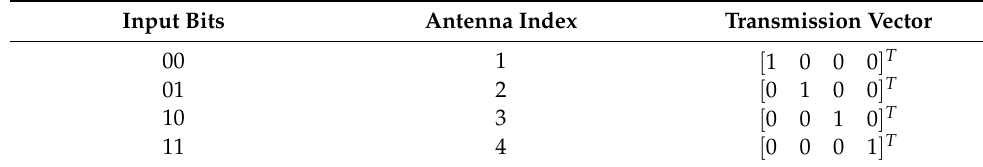
Table 1. Example of the SSK mapper